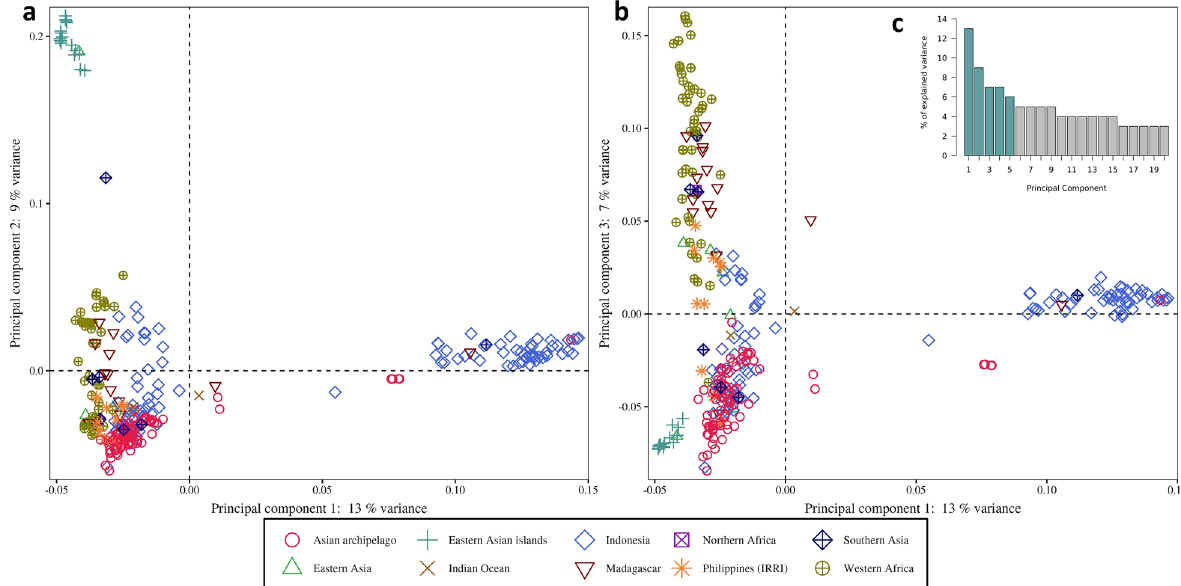
Fig. 2 Principal Component Analysis on 292 Oryza sativa sub. japonica tropical accessions from Asia and Africa: This figure shows the dimensional structuring of GJ-trp based on their geographical origins (by shape and colour) on axes 1 and 2 ( a ), and on axes 1 and 3 ( b ). The first three dimensions explain 29% of the total variance. ( c ) Percentage of explained variance for the first ten principal